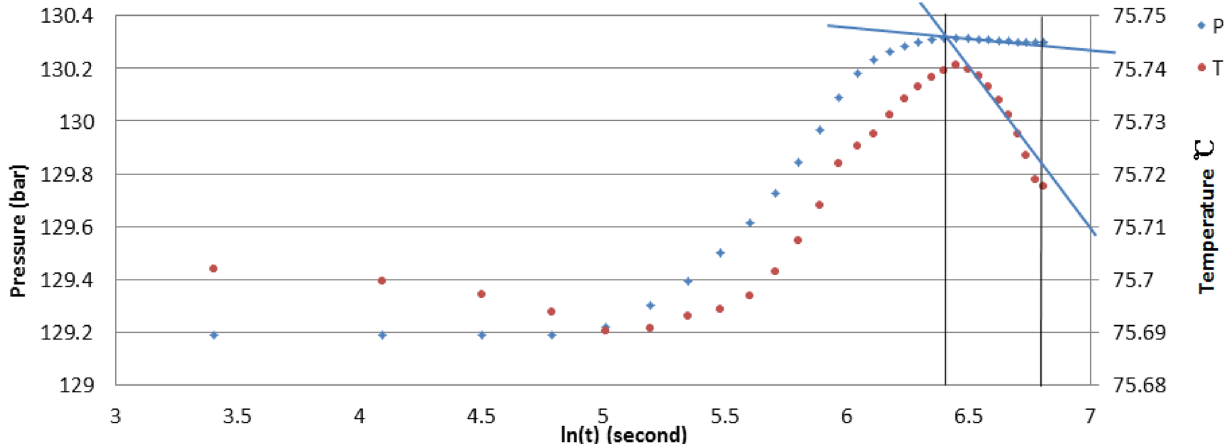
Fig.20 TTA of transient V: ε ′ = dT / dP = 0.024/0.04 = 0.6